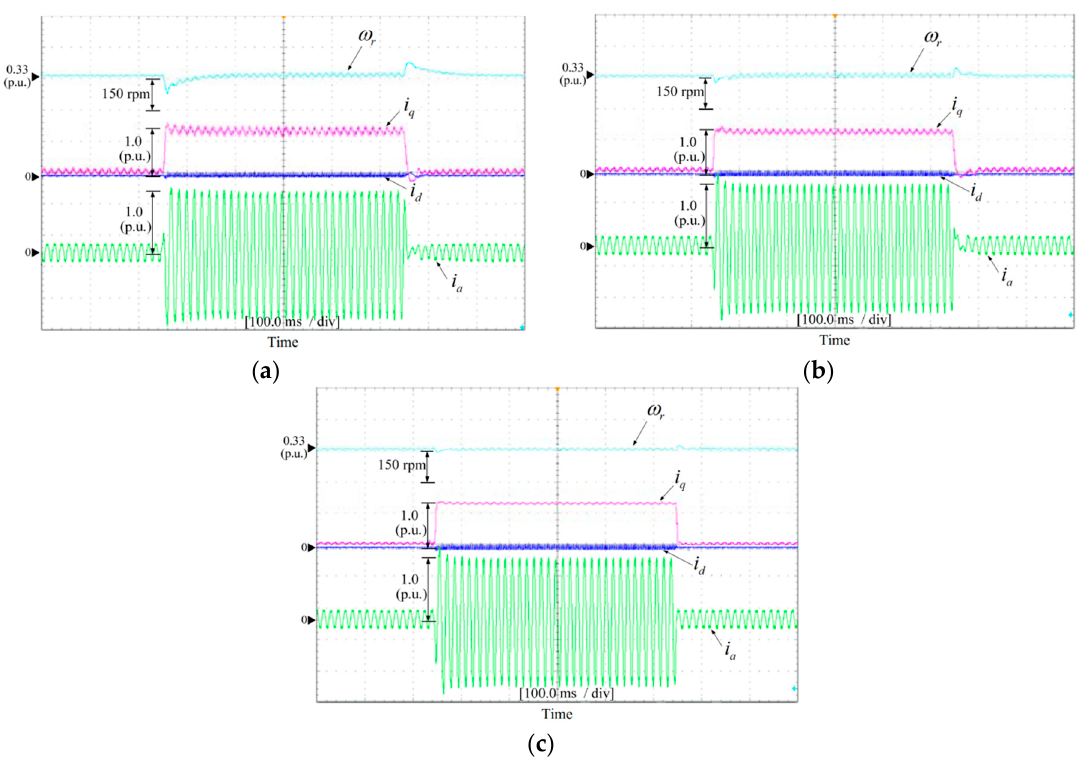
Figure 11. Simulation results under load sudden change condition: ( a ) TBC; ( b ) AIBC_FP; ( c ) Figure AIBC_AWPSO.